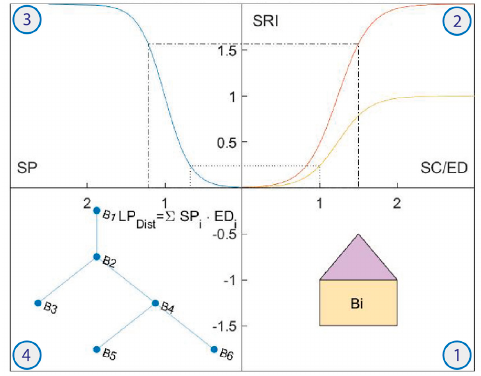
Figure 4. Assessment of the load shifting potential of the whole district.